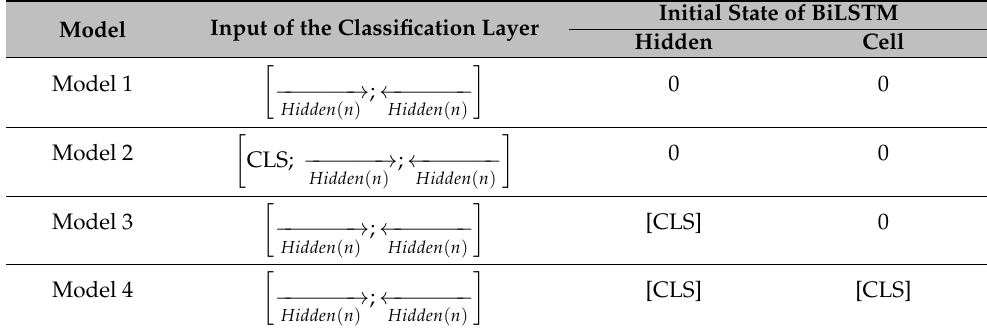
Table 5. Inputs of the classification layer and initial states of BiLSTM.